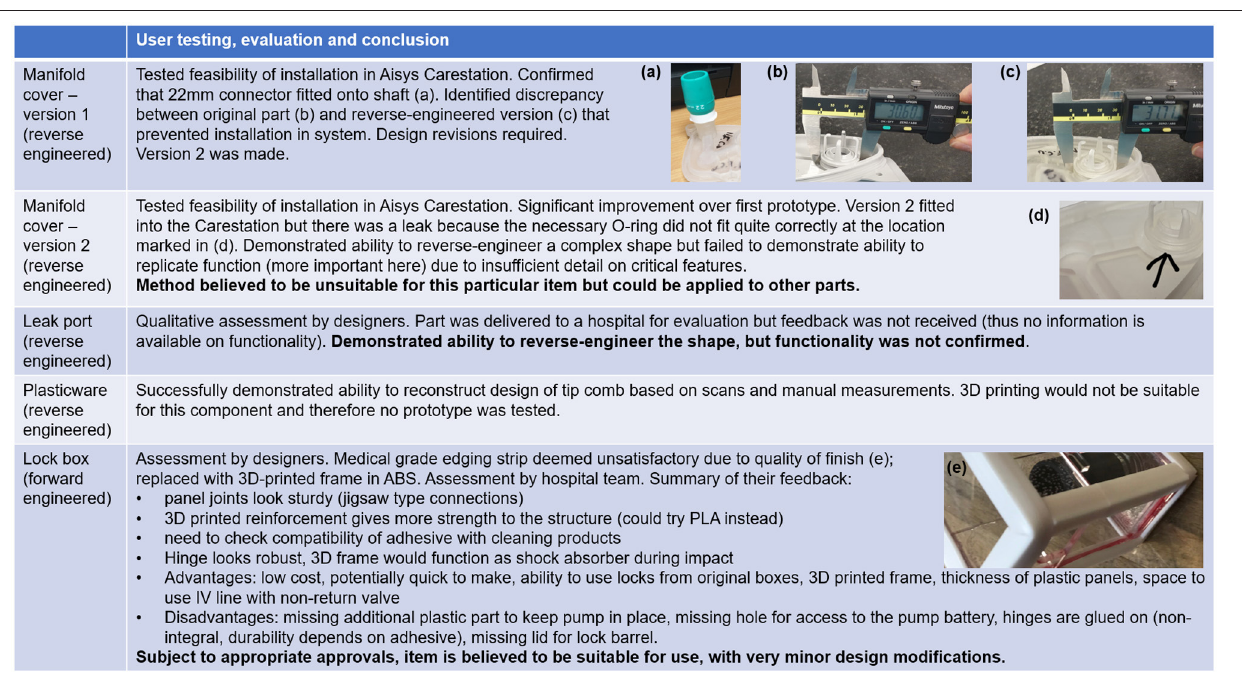
FIGURE 14 | Critical evaluation of components. Table shows user testing, evaluation and conclusion, with embedded photographs illustrating areas for improvement for each prototype examined. (a) 22mm connector fitted onto shaft of first version of reverse engineered manifold cover (b) original manifold cover, with critical dimension shown (c) first version of reverse engineered manifold cover, with discrepancy shown (d) source of leak in version 2 of the reverse engineered manifold cover (e) unsatisfactory edging on syringe pump lock